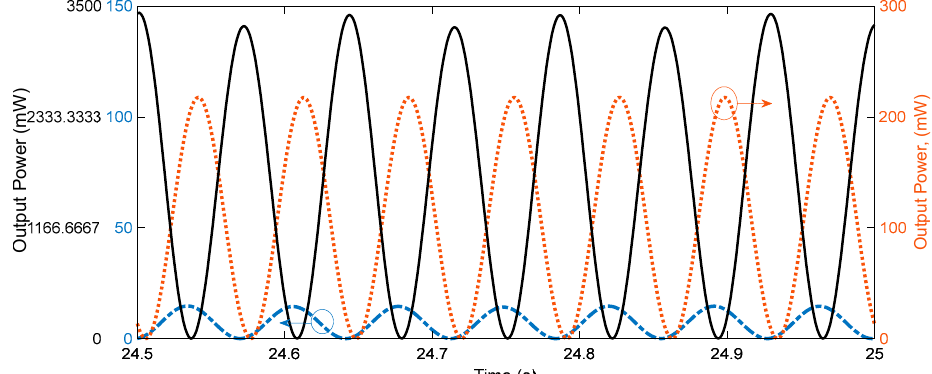
Figure 7. Output power of the tunable turbine at 𝑈 (cid:3033) = 7.0 m/s with 𝑘 (cid:2870) = 8081 N/m ( − ) and 𝑘 (cid:2870) = 2034 N/m ( ∙ − ) versus the power of the conventional turbine ( ⋯ ).